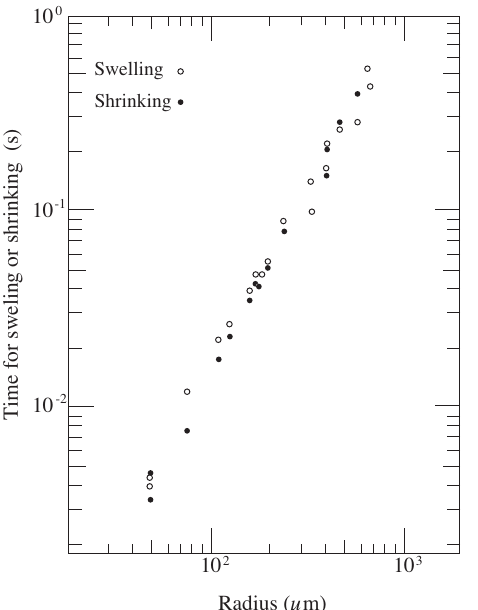
Figure 6. Swelling time and shrinking time of gels. The measurements are made in poly(N- isopropylacrylamide) gel particles [13]. Reproduced with permission from Ref. [8]. © 1986, The Physical Society of